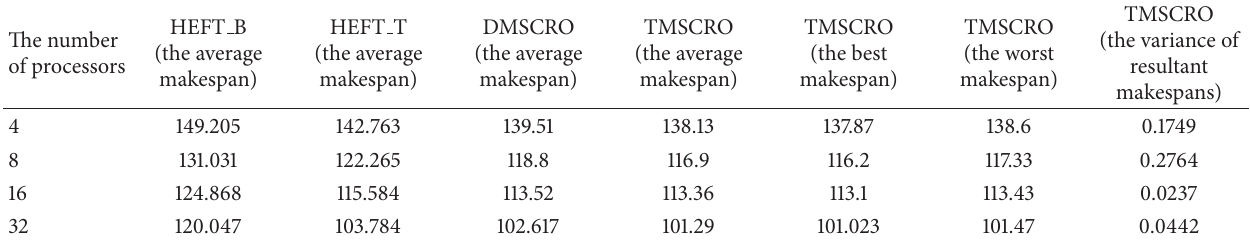
Table 9: The experiment results for the molecular dynamics code graph under different CCRs; the number of processors is 16.